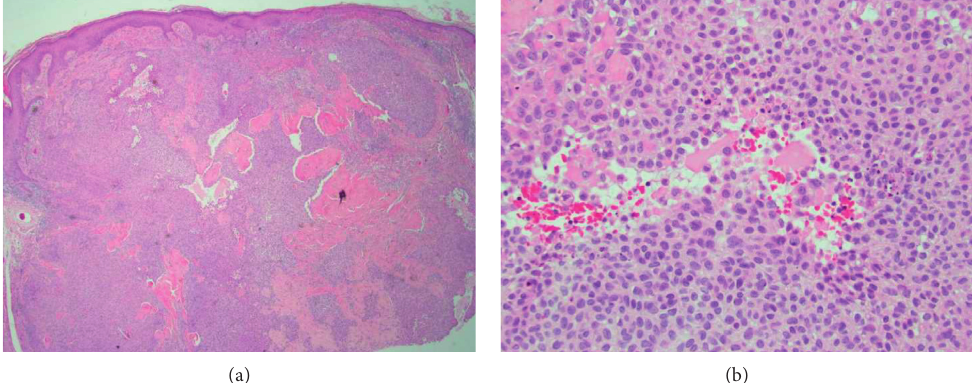
Figure 2: (a) Scanning micrograph of the porocarcinoma shows an expansile tumor arising from the epidermis with extension deep into the reticular dermis (hematoxylin and eosin, 4x). (b) Higher power shows focal necrosis of the tumor which displays cytologic atypia, including mitotic figures (hematoxylin and eosin,